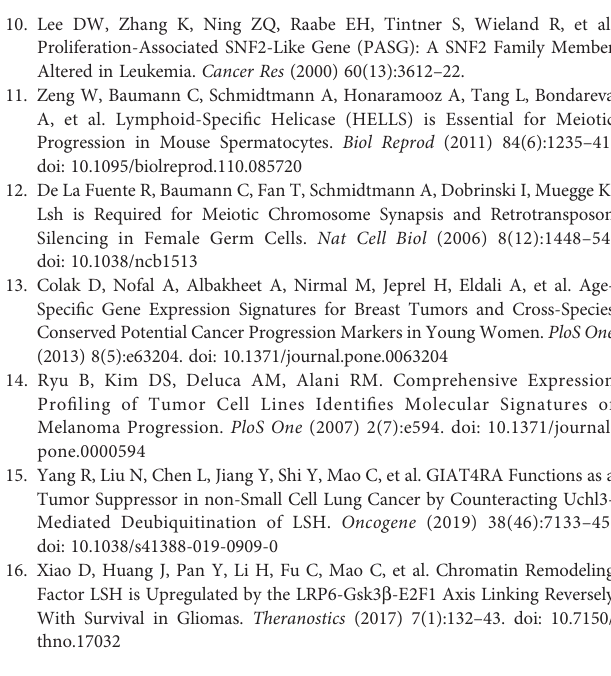
Supplementary Figure 1 | Details of HELLS mRNA expression in tissues and cell lines. (A) Details of HELLS mRNA expression in different tissues, (B) T Details of HELLS mRNA expression in different cell lines. Supplementary Figure 2 | Correlations between HELLS and DSS in 11 cancers. DSS K-M curve for HELLS 11 cancer types. The unit of X-axis is month. (A) ACC, (B) CESC, (C) COAD, (D) KIRC, (E) KIRP, (F) LGG, (G) LIHC, (H) LUAD, (I) MESO, (J) SARC, (K) UCS. Supplementary Figure 3 | Correlations between HELLS and PFI in 8 cancers. PFI K-M curve for HELLS 8 cancer types. The unit of X-axis is month. (A) ACC, (B) KIRP, (C) LIHC, (D) LUAD, (E) MESO, (F) PAAD, (G) PRAD, (H) SARC. Supplementary Figure 4 | Correlations between HELLS expression and immune subtype in 14 cancers. (A) BRCA, (B) COAD, (C) ESCA (D) HNSC, (E) KICH, (F) KIRC, (G) OV, (H) PCPG, (I) READ, (J) SKCM, (K) STAD, (L) TGCT, (M) THCA, (N) UCEC. Supplementary Figure 5 | Correlations between HELLS expression and molecular subtypes in 8 cancers. (A) BRCA, (B) COAD, (C) HNSC, (D) OV, (E) PCPG, (F) SKCM, (G) STAD, (H)